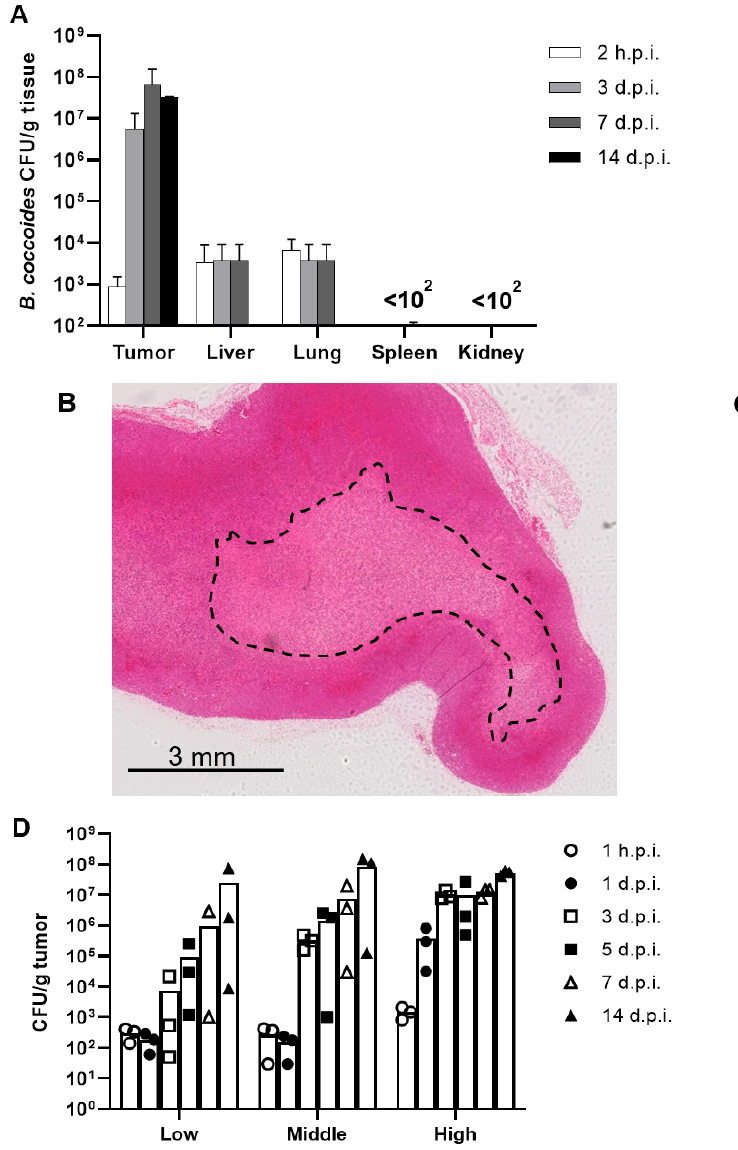
Figure 3. Biodistribution of B. coccoides JCM1395 T after its intravenous administration. ( A )